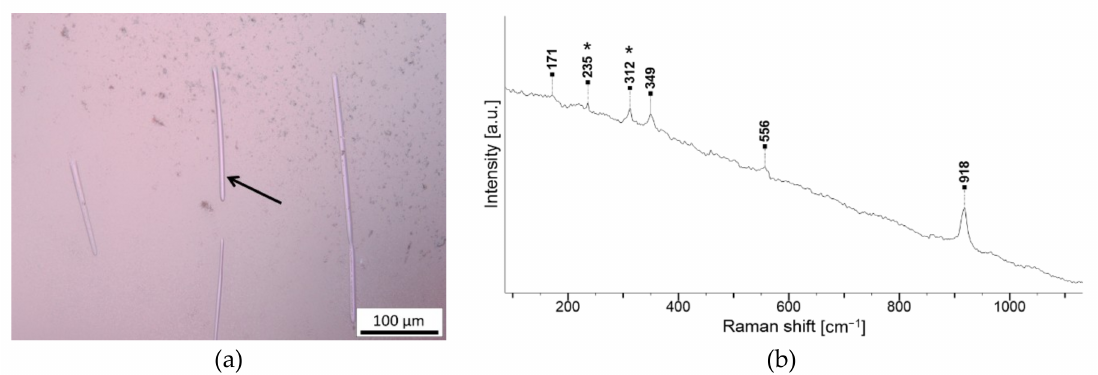
Figure 15. Inclusions in garnet G5 of fibulae NA806 and G2 of fibulae NA892. Reflected light, parallel polars. ( a ) Inclusions of sillimanite in garnet G5 of fibula NA806; ( b ) Raman spectrum of fibre-like inclusion in almandine, with band at 235 cm − 1 , indicative for sillimanite (black asterisk).